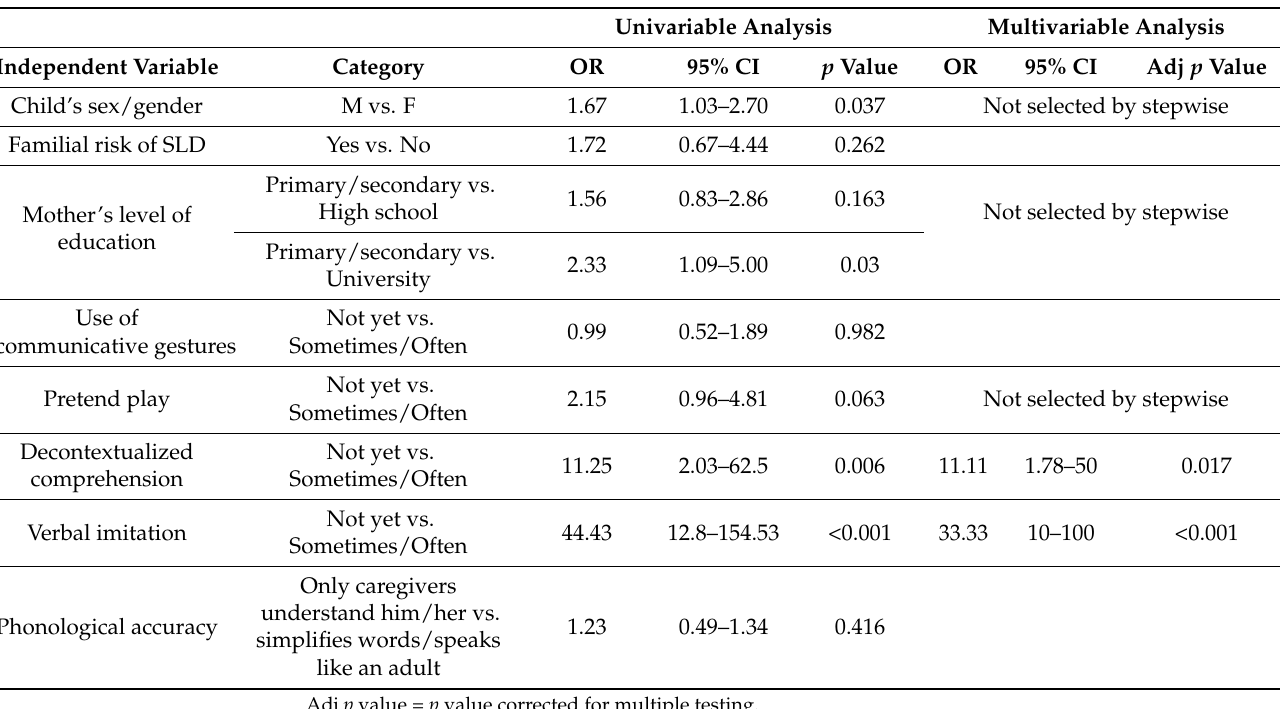
Table 5. Details of the univariable analyses and the best multivariable model, with vocabulary size as the dependent variable.